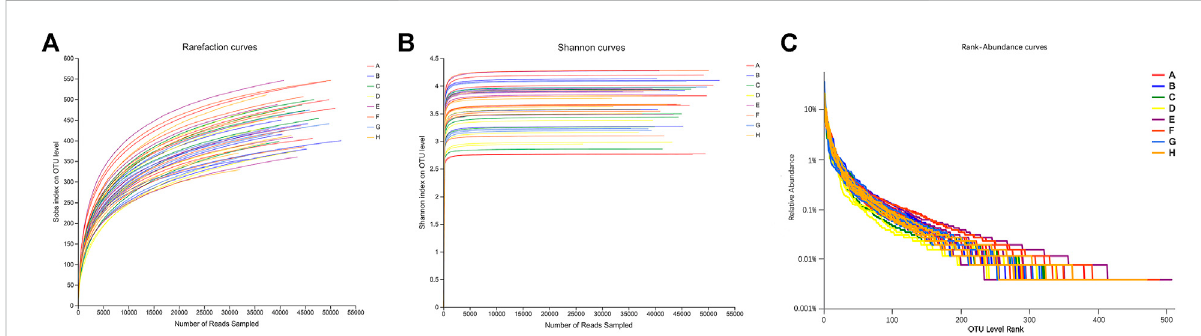
FIGURE 4 Sequencing Dilution Curve (A) , Shannon-Wiener Curve (B) and Rank-Abundance Curve (C) of Intestinal Micro fl ora in Fecal Samples of Rats in Each Group. Note: A.Blank group B. DN model group C.Irbesartan group D. Cornus of fi cinalis group E. Wine Cornus of fi cinalis group F. Wine honey Cornus of fi cinalis group G. Auxiliary wine group H. Auxiliary wine honey group.